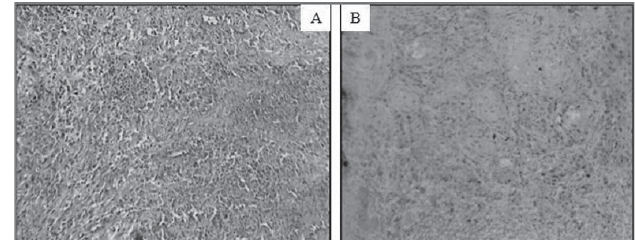
Fig. 8 IHC staining with p53 (10x) showing well differentiated squamous cell carcinoma (A) with increased number of p53 positive cells as compared to dysplastic epithelium